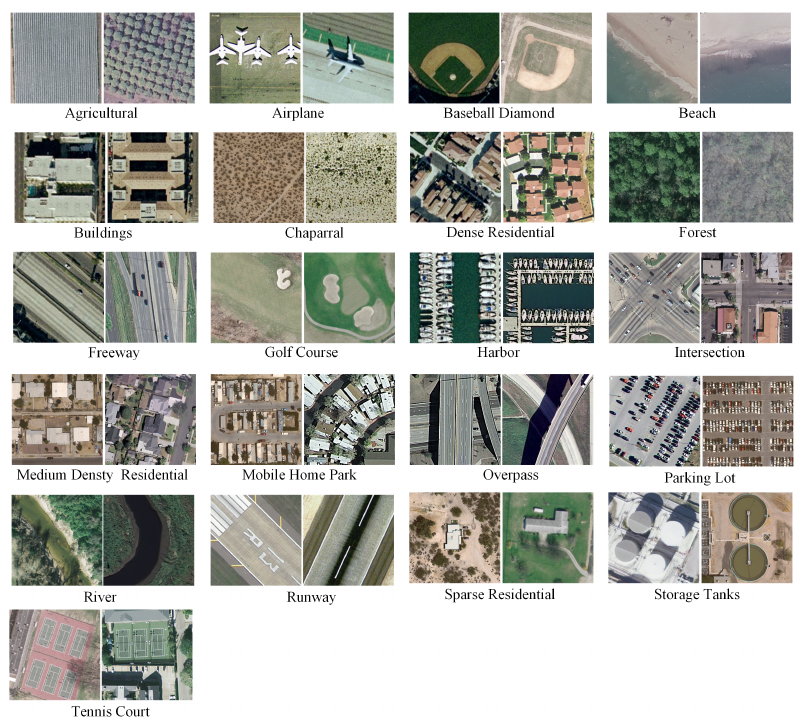
Figure 3. Two examples of ground truth images of each scene category in the UC data